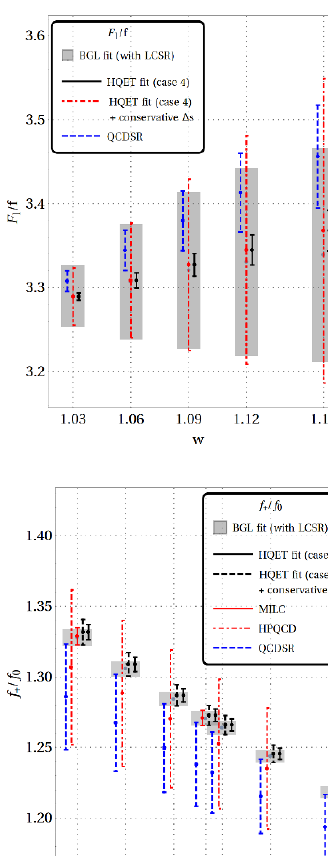
( w ) =f ( w ). + 0 =f are fully consistent with that 1